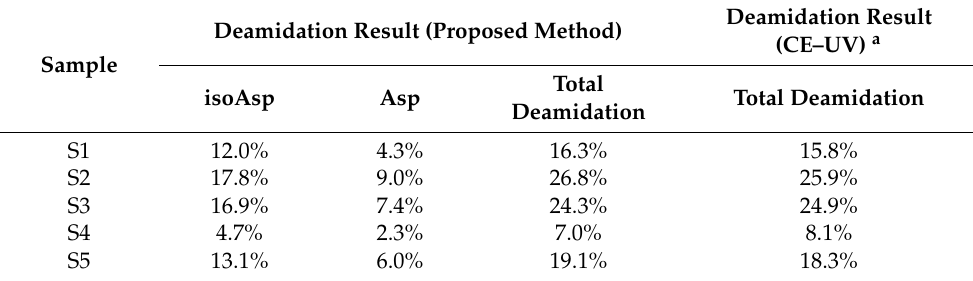
Table 1. Comparison of the quantification results of isoAsp and Asp determined in five batches of samples using both the proposed method and our previously reported CE–UV method.